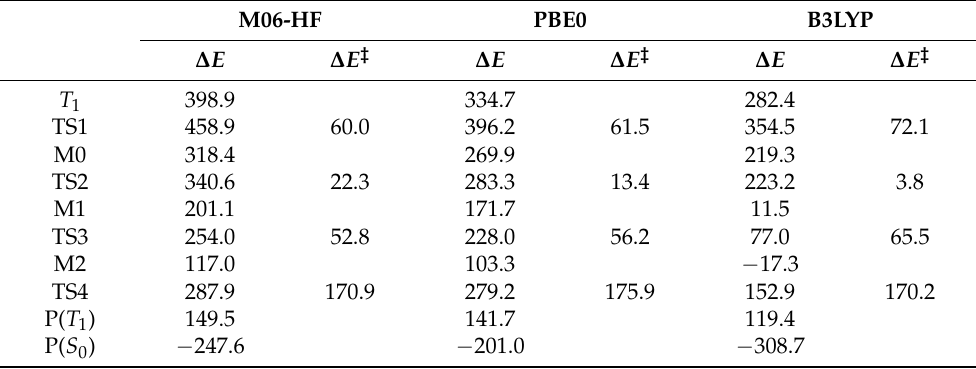
Table 3. Energetic properties (in kJmol − 1 ) of the relevant species along the reaction path: ∆ E , relative to the ground-state ( S 0 ) of ATZ; energy barrier ∆ E ‡ = E ‡ − E min relative to the minimum prior to the